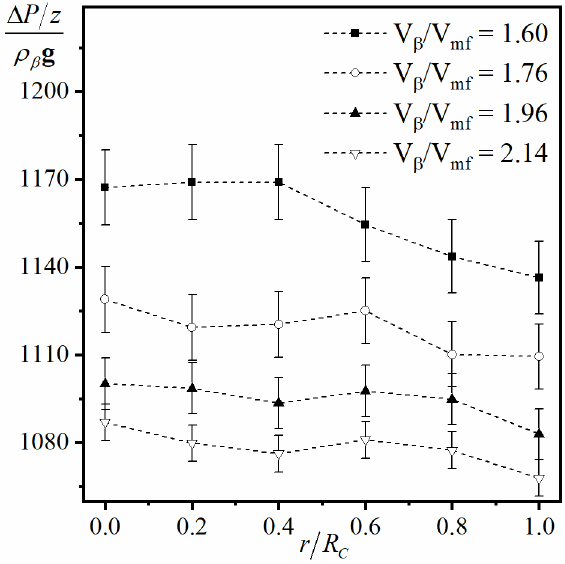
Figure 3. Radial dimensionless pressure drops profiles for a fluidized bed packed with aluminum oxide particles operating at different superficial gas velocities.